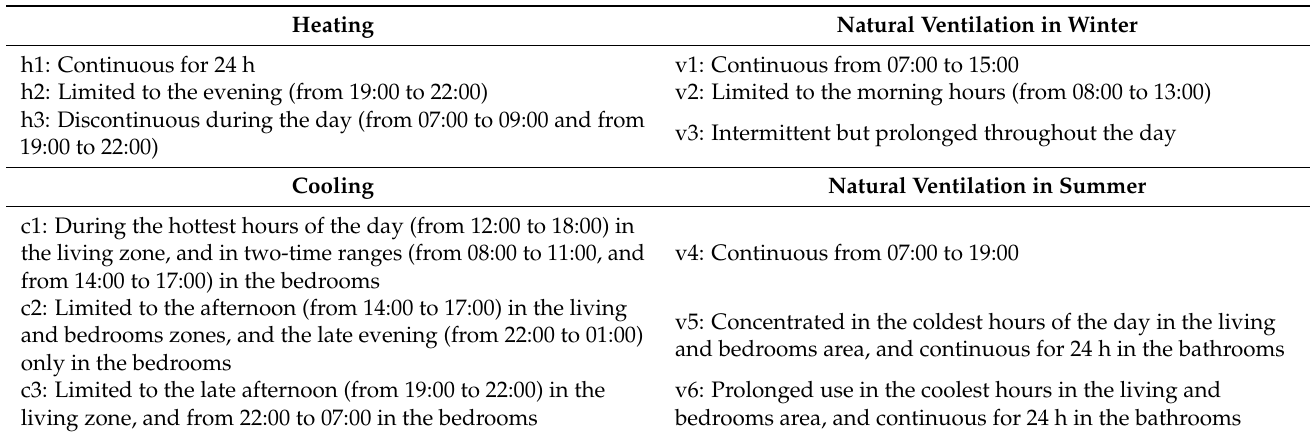
Table 1. Daily heating, cooling, and natural ventilation schedules